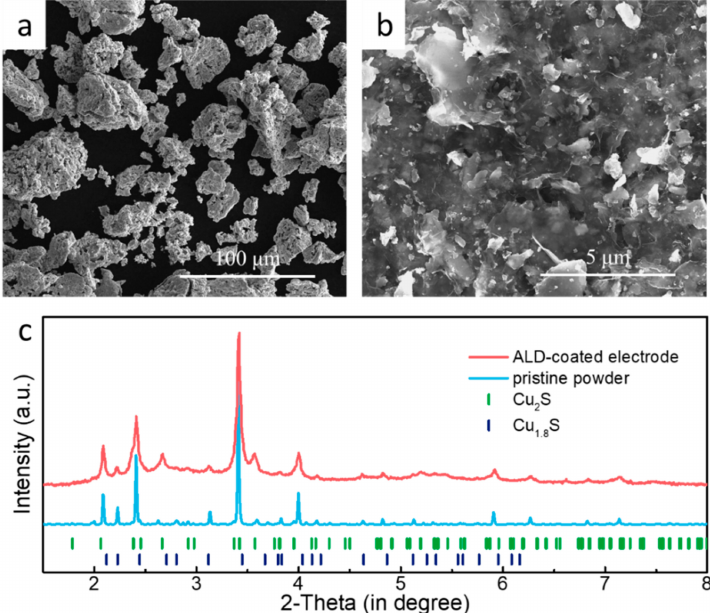
Figure 1. SEM images of ( a ) the as-received Cu 2 S powder and ( b ) Atomic Layer deposition (ALD)-coated Cu 2 S@NG electrode. ( c ) XRD characterizations of the as-received Cu 2 S powder and ALD-coated Cu 2 S@NG electrode.